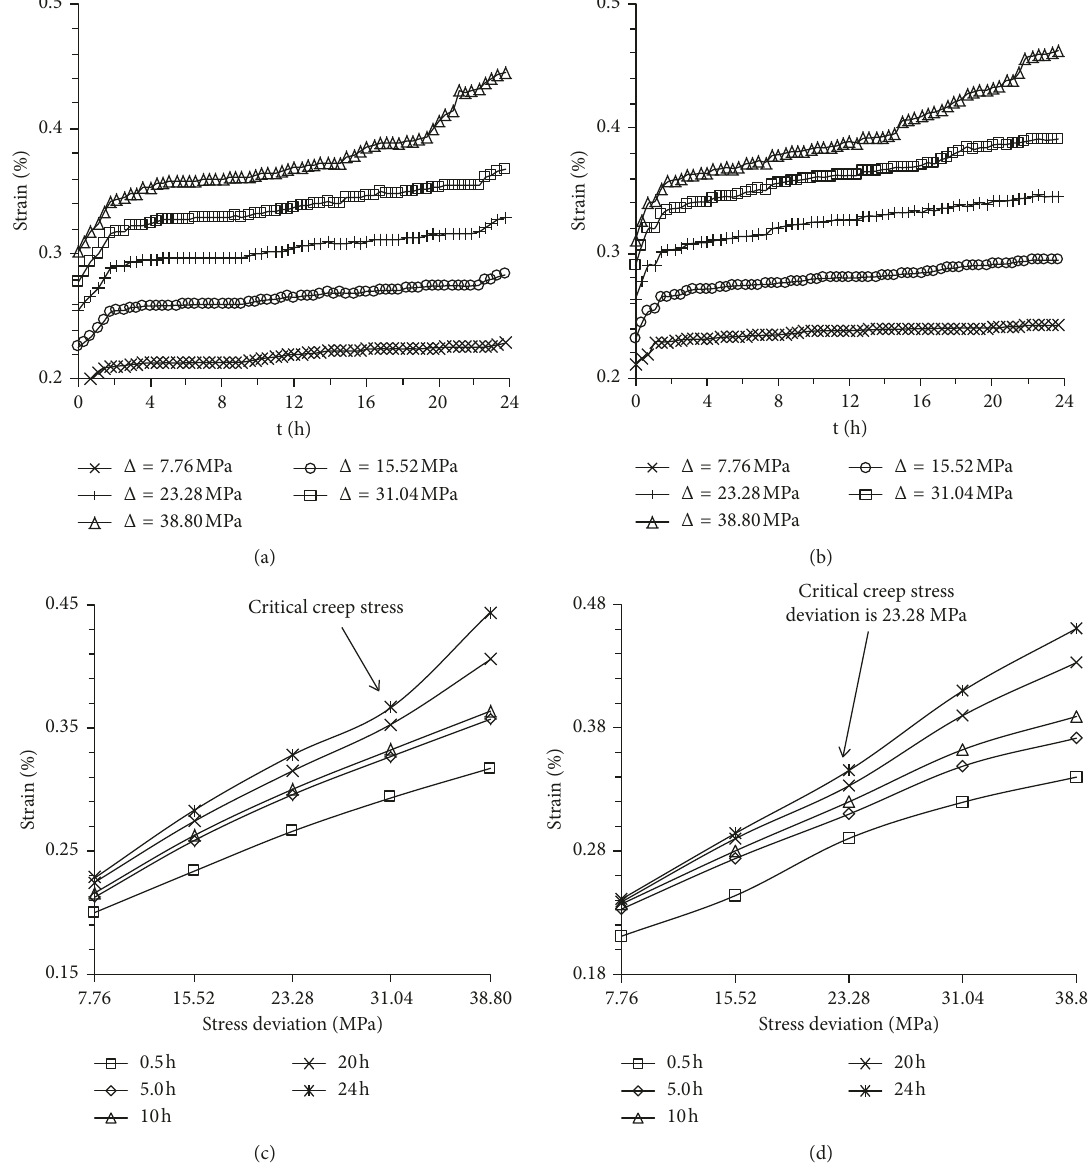
50 ° C). (b) Strain-time curves ( T (cid:30) (cid:30) 70 ° C). (cid:30)